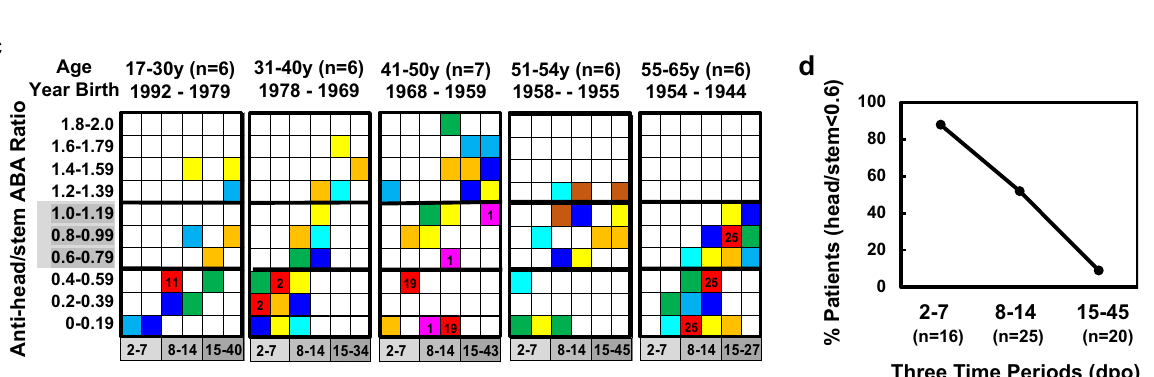
Three Time Periods (dpo) (No. of Patients) Figure 2. Kinetics of anti-HA antibody responses. Serum samples were tested by HAI assays using wt-CA/09, VN assays using MX/09, and BLI assays using rHA-head from wt-CA/09 and rHA-stem from A/ Michigan/45/2015. ( a ) HAI and VN antibody response kinetics in 8 patients are illustrated by black lines and red lines, respectively. ( b ) Anti-HA-head and anti-HA-stem antibody response kinetics are illustrated by black lines and red lines, respectively. ( c ) Ratio of anti-head/stem ABA in 31 patients was categorized into 5 age- groups. Each colored square in 5 age-groups represents the ratio in each serum sample. Each color(yellow, orange, blue, dark blue, green, cyan, brown, red, and pink) in each age group represented the ratio(s) from the same patient’s serum sample(s) that were collected 1–4 times at 3 different time periods of 2–7 dpo, 8–14 dpo, and 15–45 dpo. Red and pink square with patient numbers represented 5 fatal patients; other color squares without patient numbers represented 26 surviving patients. ( d ) Summary of the percentage of 31 patients with ratio of anti-head/stem ABA < 0.6. We completed 3 independent HAI and VN assays. BLI assays were performed in 2 independent